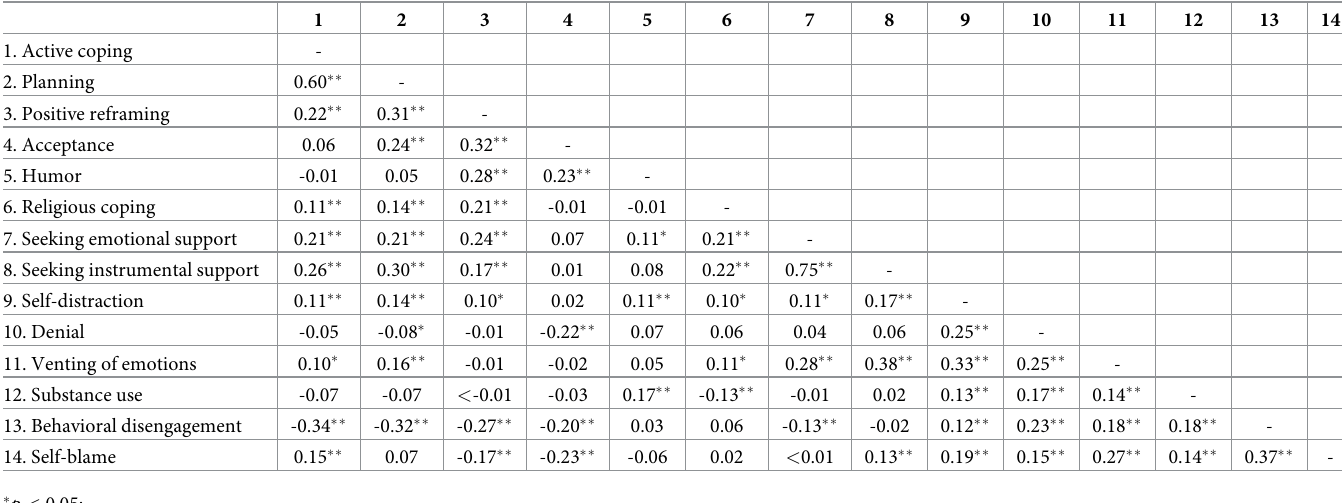
Table 4. Pearson’s correlation coefficients between the strategies of coping with